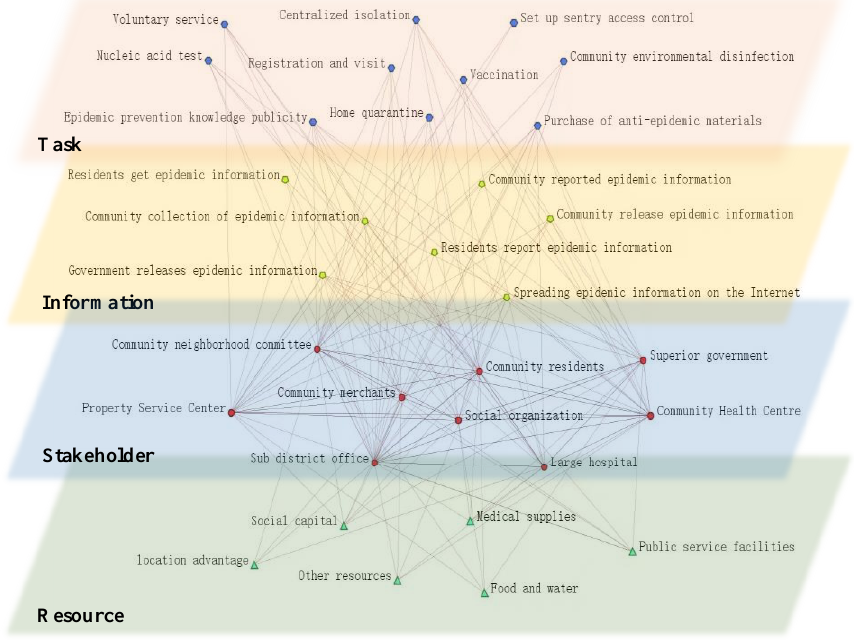
Figure 1. The anti-epidemic network and relationships in urban communities under a normal